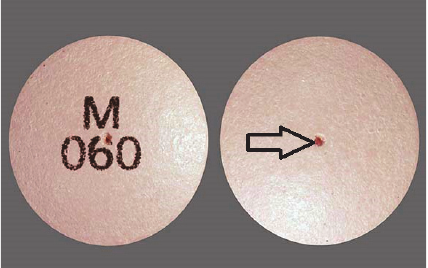
Figure2: An originalnifedipinepill witha holeforsustainedrelease